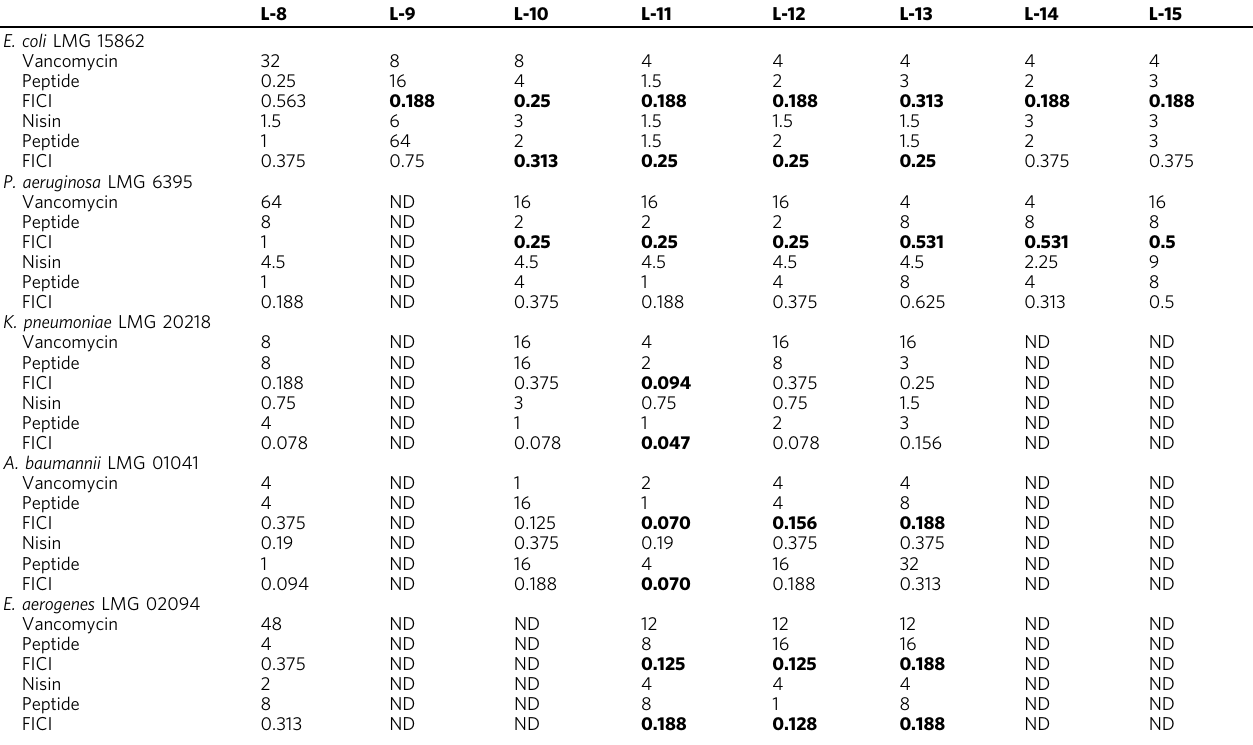
Table 3 Combined activity of L-peptides and either vancomycin or nisin against fi ve Gram-negative pathogens.